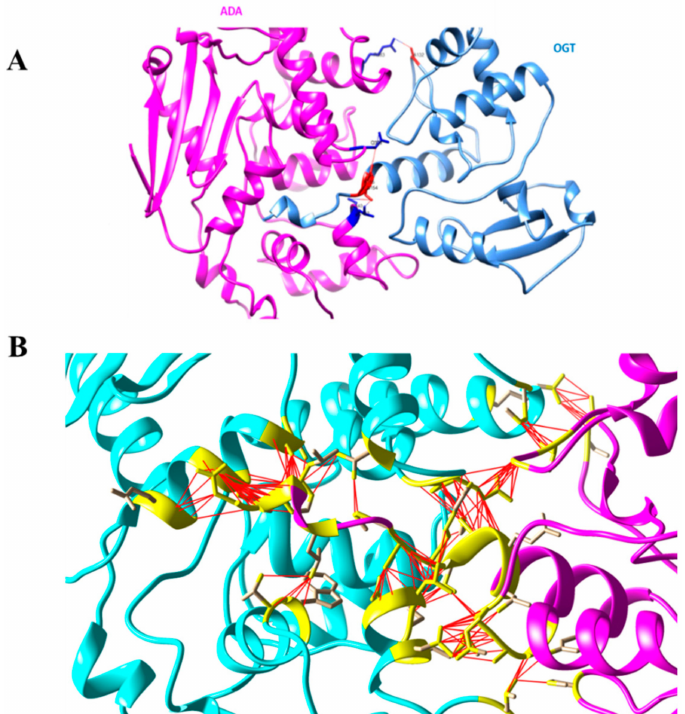
Figure 5. ( A ). Ribbon model of the Ada-AlkA / Ogt complex showing the predicted hydrogen bonds at the protein–protein interface. ( B ). Detailed description of the Ada-AlkA / Ogt interactions. Residues involved in the interaction are in yellow while the red lines represent the connection between residues. Images were generated by the CHIMERA